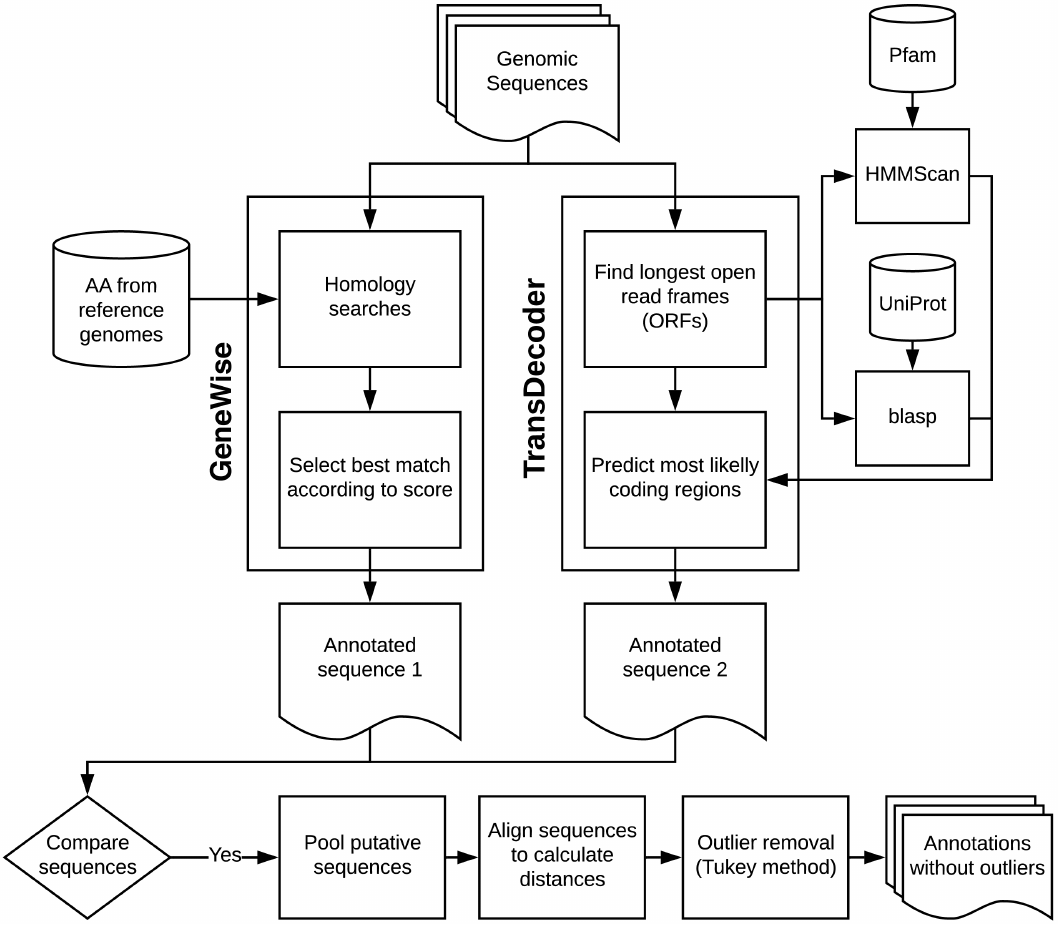
Figure 1. Main steps of the protein annotation